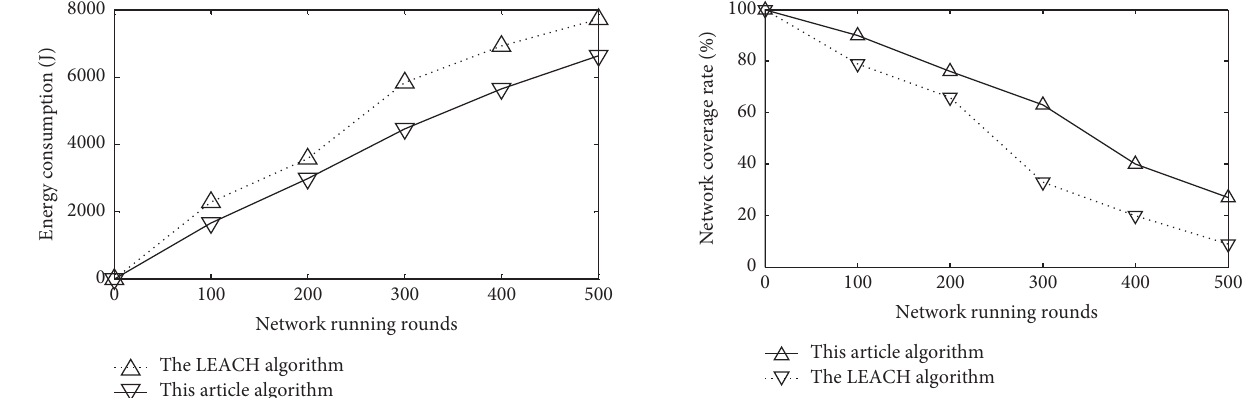
Figure 7: Network coverage rate comparison in this article’s al- gorithm and the LEACH algorithm under different network running rounds.